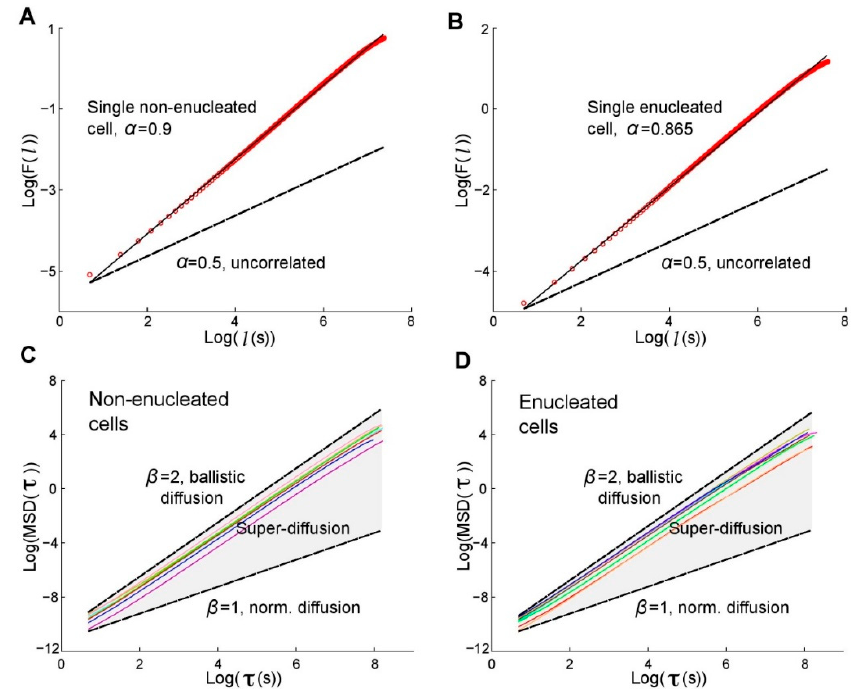
Figure 1. Root mean square fluctuation and Mean Square Displacement (MSD) of the trajectories of non-enucleated and enucleated amoebas. (Part of this figure has been reported previously by the authors in ref. [74].) Log-log plot of rms fluctuation F vs. l step for a prototype non-enucleated cell ( A ) and a prototype enucleated cell ( B ). The slope for the non-enucleated cell was α = 0.9, while for the enucleated it was α = 0.865, indicating non-trivial positive long-term correlations in both cases. In ( C ) and ( D ), log-log plots of MSD against the time interval τ , for 8 prototypic non-enucleated and 8 enucleated cells, respectively. β = 1 indicates normal di ff usion while β = 2 indicates ballistic di ff usion. The grey region defines the area of super-di ff usion, in which all experimental slopes are contained. The fact that τ max = 1 / 4th of the data length, implies that super-di ff usion holds in large